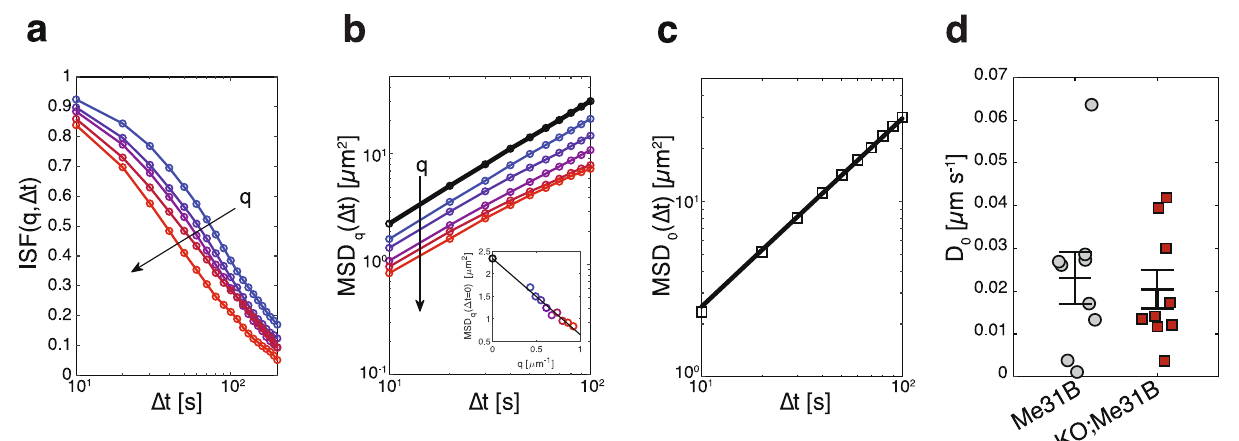
Fig. 5 Lack of Hecw does not alter RNPs mobility. a Representative intermediate scattering functions f q ; Δ t ð Þ obtained from Differential Dynamic Microscopy (DDM) analysis of an image sequence of a KO;Me31B::GFP egg chamber plotted as a function of the time delay 4 t for different values of the wave vector q in the range 0 : 4 (cid:2) 0 : 8 μ m (cid:2) 1 . b From each of the curves shown in ( a ), a q -dependent estimate of the mean square displacement MSD Δ t ð Þ (cid:3) (cid:2) 4 f q ; Δ t ð Þ can be obtained (coloured symbols). Black circles correspond to the best estimate for the average mean square displacement q q 2 ln MSD Δ t ð Þ of the RNPs, obtained by extrapolating MSD Δ t ð Þ to q ¼ 0 at fi xed Δ t . The extrapolation procedure is illustrated in the inset for the representative q 0 case Δ t ¼ 10 s : c Average mean square displacement MSD 0 Δ t ð Þ (symbols) of the RNPs in the considered egg chamber, displaying a characteristic linear dependence on the delay time Δ t , which is indicative of a random, diffusive-like motion. An effective diffusion coef fi cient D 0 can be obtained by fi tting a linear model MSD 0 Δ t ð Þ ¼ 4 D 0 Δ t to the data (continuous black line). d DDM analysis of N = 18 egg chambers shows no signi fi cant difference in the RNP mobility between wild-type (Me31B, D 0 ; WT ¼ 0 : 023 ± 0 : 006 μ m 2 = s N = 9) and Hecw KO egg chambers (KO;Me31B, D 0 ; KO ¼ 0 : 021 ± 0 : 005 μ m 2 = s, N = 9). See also Supplementary Fig. 5h,